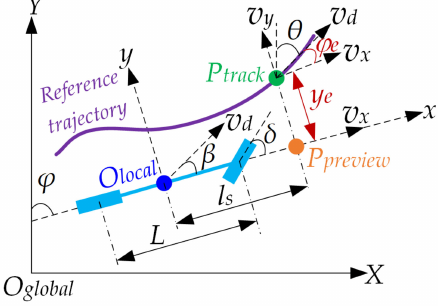
Figure 1. Trajectory tracking